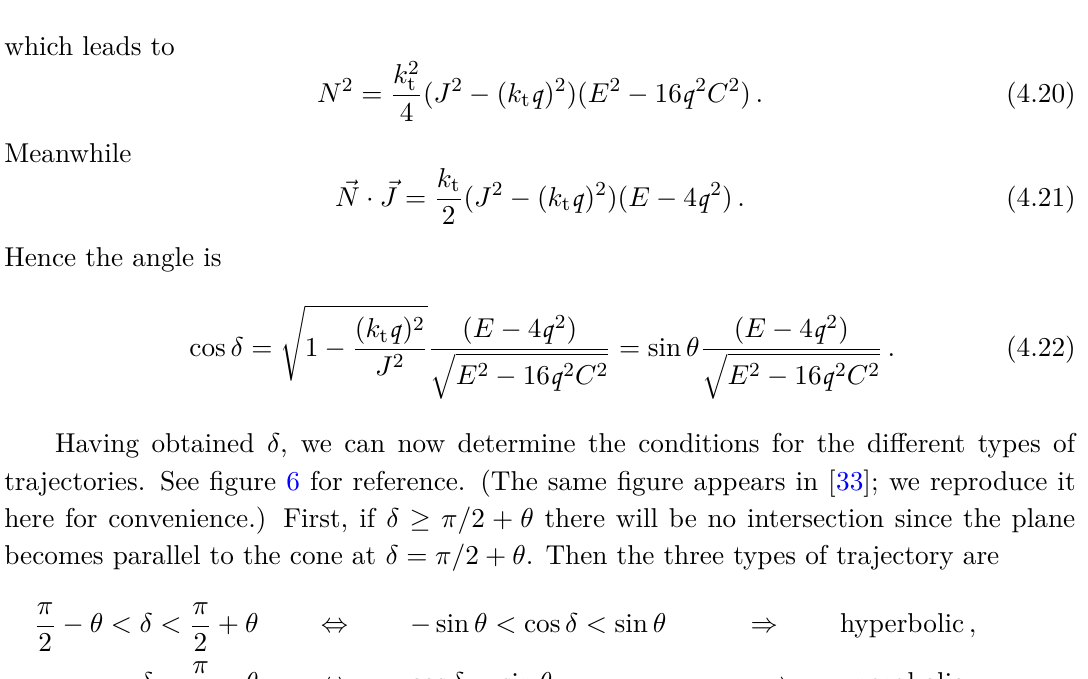
Figure 6 . The trajectory (highlighted in red) is the intersection of a cone, with axis sgn( q ) ~J and opening angle θ , and a plane with outward normal sgn( q ) ~N making angle δ with the axis of the